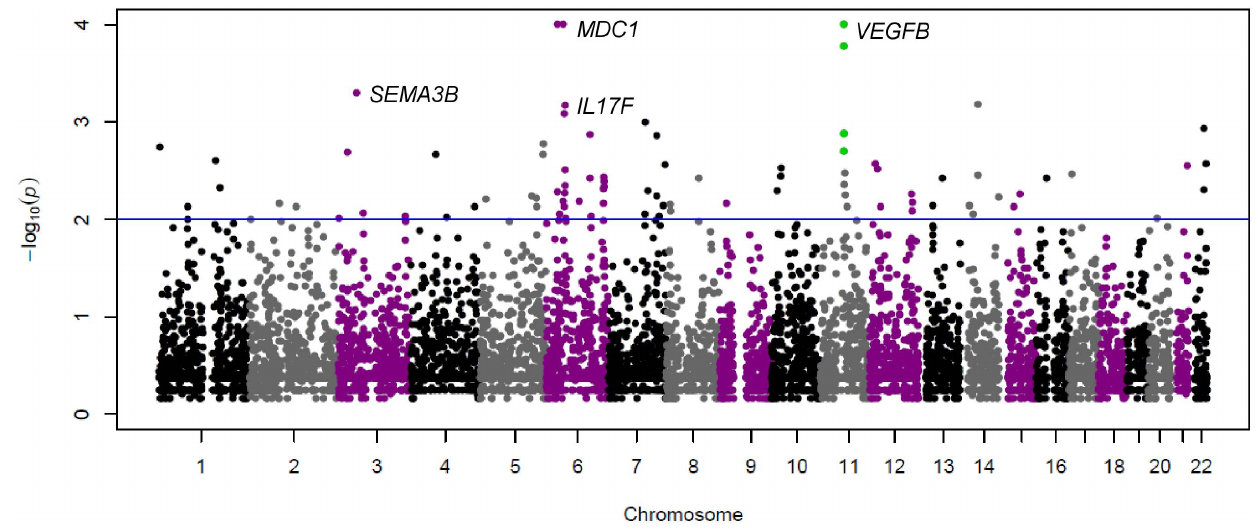
Figure 4. Manhattan plot of iHS window p-values across all chromosomes in Collas. The y-axis denotes the empirical p-value of the windows. The blue line indicates the 1% cut off. 12 windows in the top 1% of Collas were excluded since they overlapped with the top 5% of Wichı´ iHS windows. The highest empirical p-values in each bin were 0 and thus arbitrarily set to 0.001 to display them as highest values as the calculation of log 10 (0) is not permitted. Chromosome 11 harbours the top window, with the highest p-value and greatest bin-score containing VEGFB ; windows 6 1 MB in this region are highlighted in green. The highest ranking window in the bin containing . 80 SNPs included MDC1 , a gene controlling DNA repair in response to hypoxia. The top window of the bin with 60–79 SNPs, which is located 16 Mb downstream from MDC1 , did not contain plausible candidate genes. SEMA3B is involved in neuron development and IL17F in can inhibit angiogenesis. The highest window on chromosome 14 did not contain any genes.